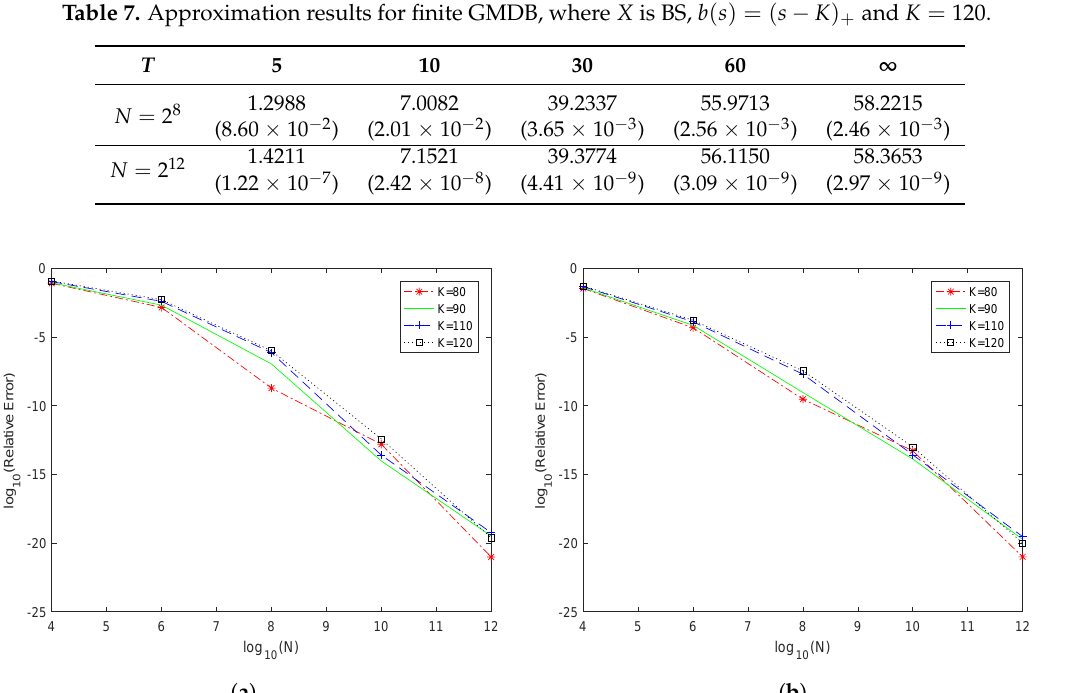
Figure 1. Relative errors with payoff b ( s ) = ( s − K ) + : ( a ) BS model; ( b ) Kou model.